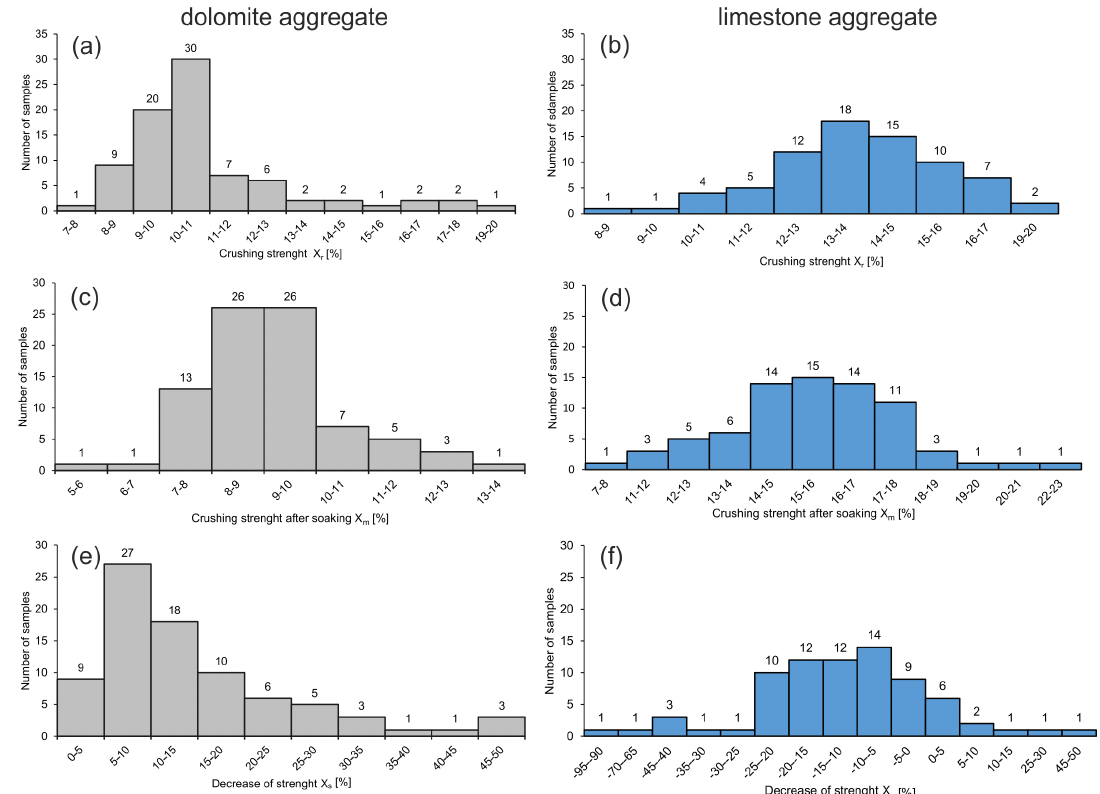
Figure 6. Distribution histograms of the values of geotechnical parameters for carbonate aggregates: crushing strength X r of dolomite ( a ) and limestone ( b ) aggregate; crushing strength after soaking X m of dolomite ( c ) and limestone ( d ) aggregate; decrease of strength X s of dolomite ( e ) and limestone ( f ) aggregate.